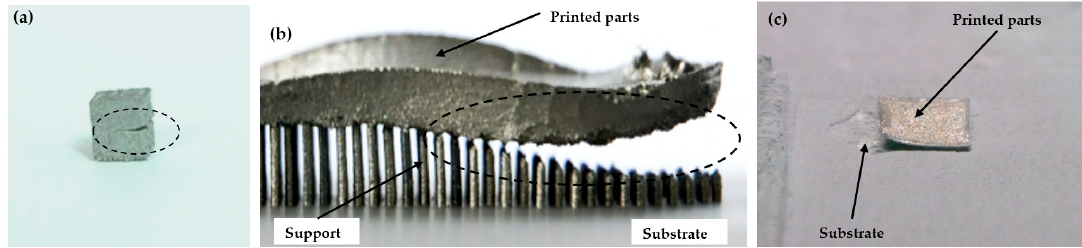
Figure 2. Delamination ( a ), support cracking ( b ), and flaking ( c ).